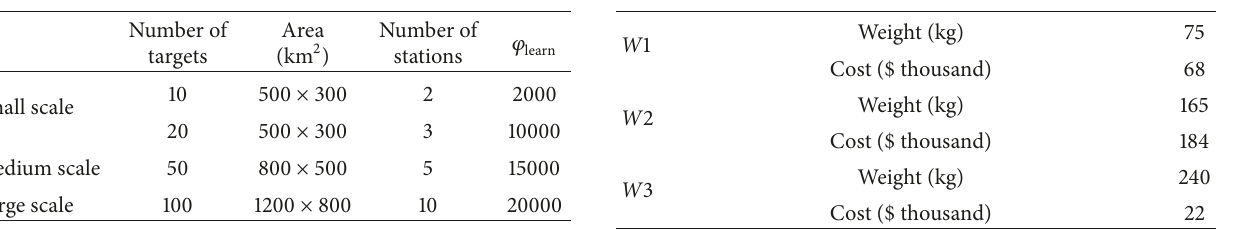
Table 2: Experimental scale.